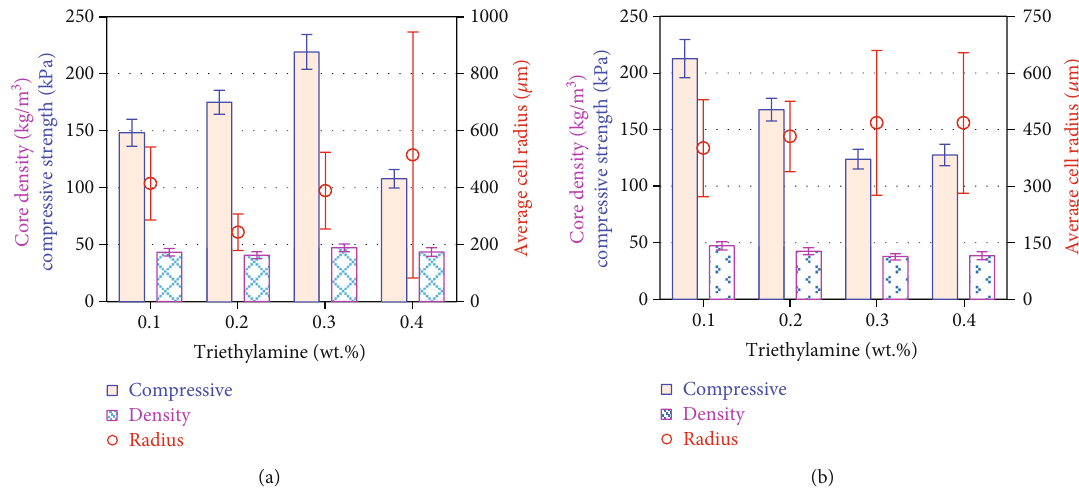
Figure 9: Dependence of the properties of rigid PU foams on the triethylamine content.